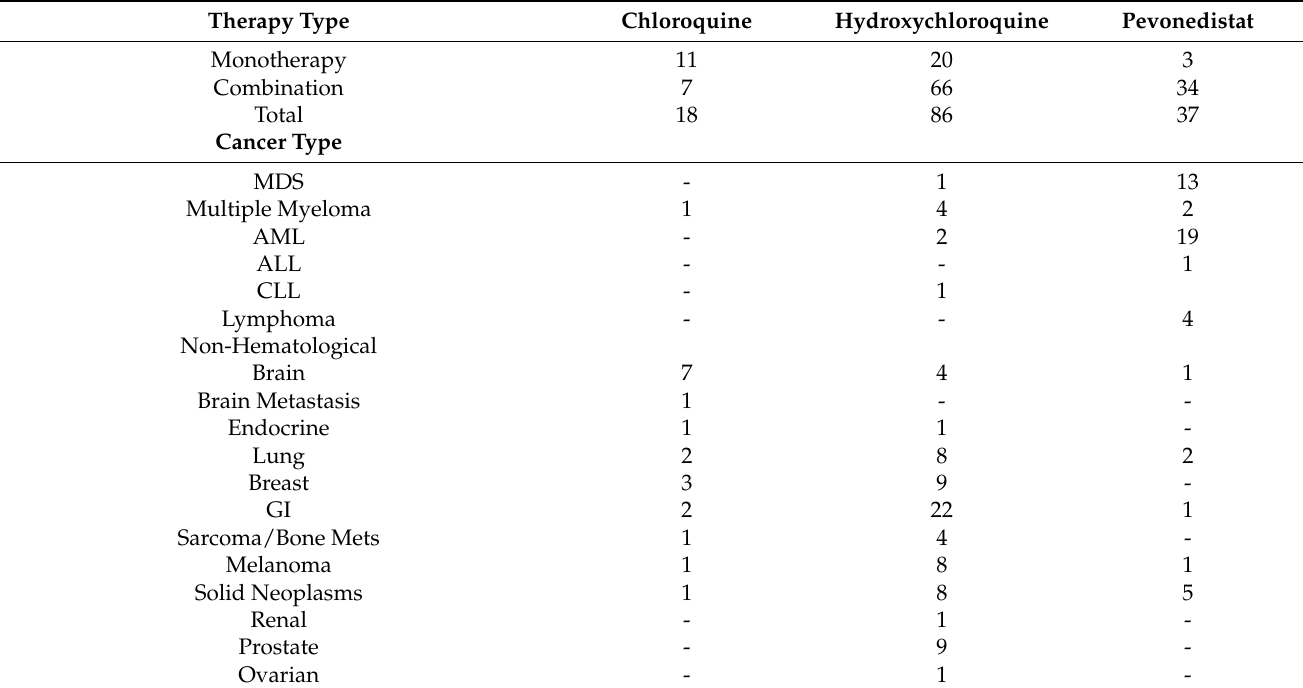
Table 1. Characteristics of clinical trials of Chloroquine, Hydroxychloroquine, and Pevonedistat in clinical trials of cancer treatment by therapy type (monotherapy or combination with chemo), cancer type (liquid or solid), and trial